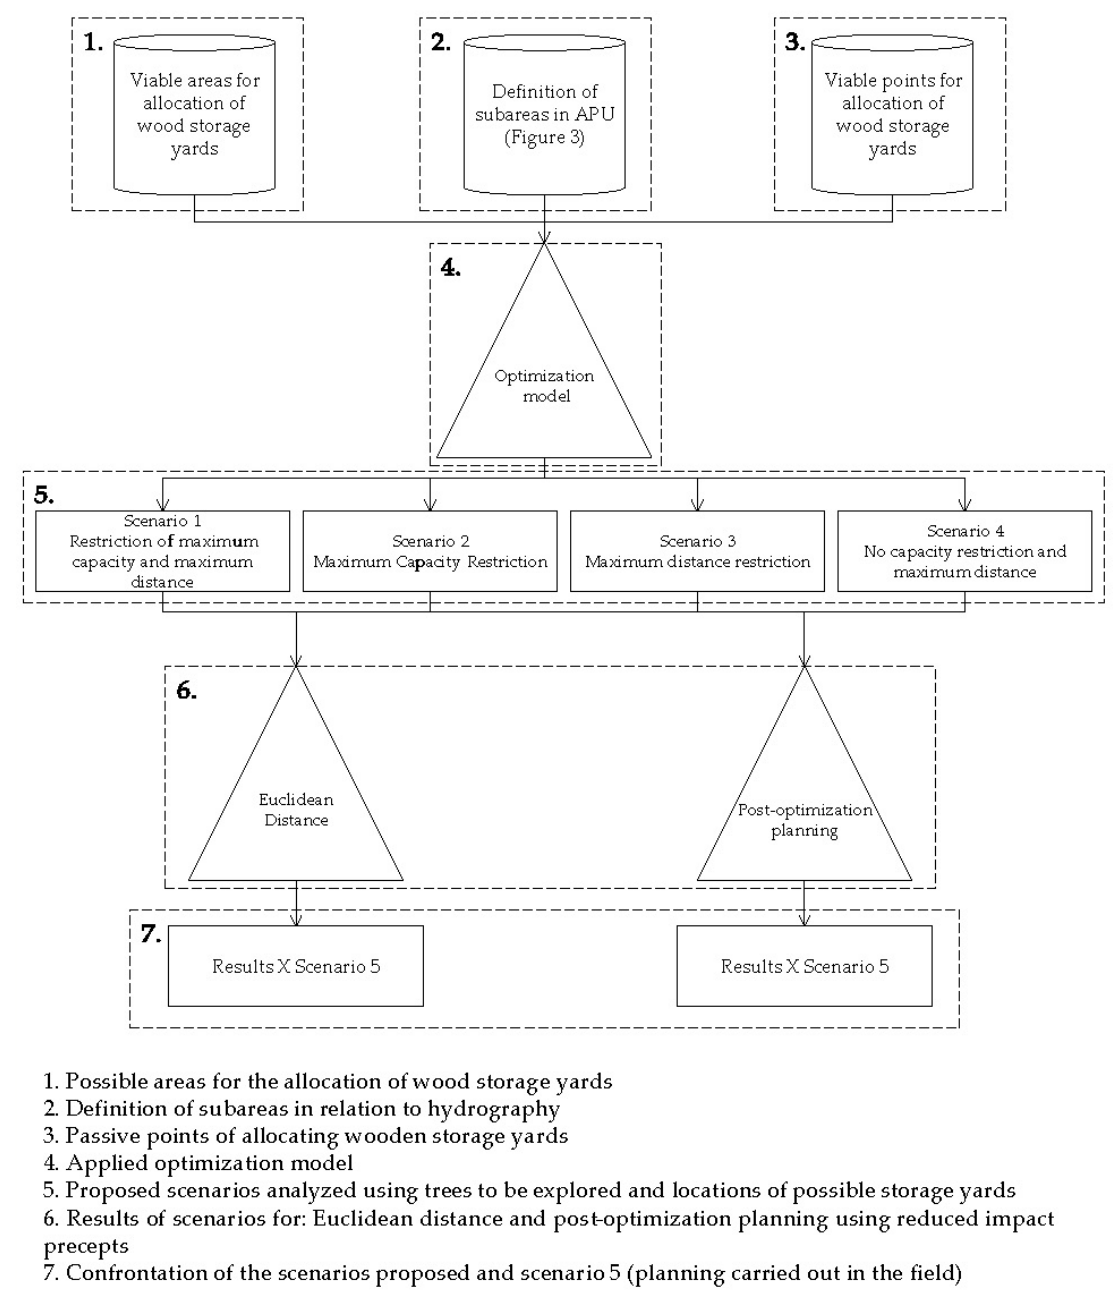
Figure 4. Scheme of the input data of the model, analysis, and results.